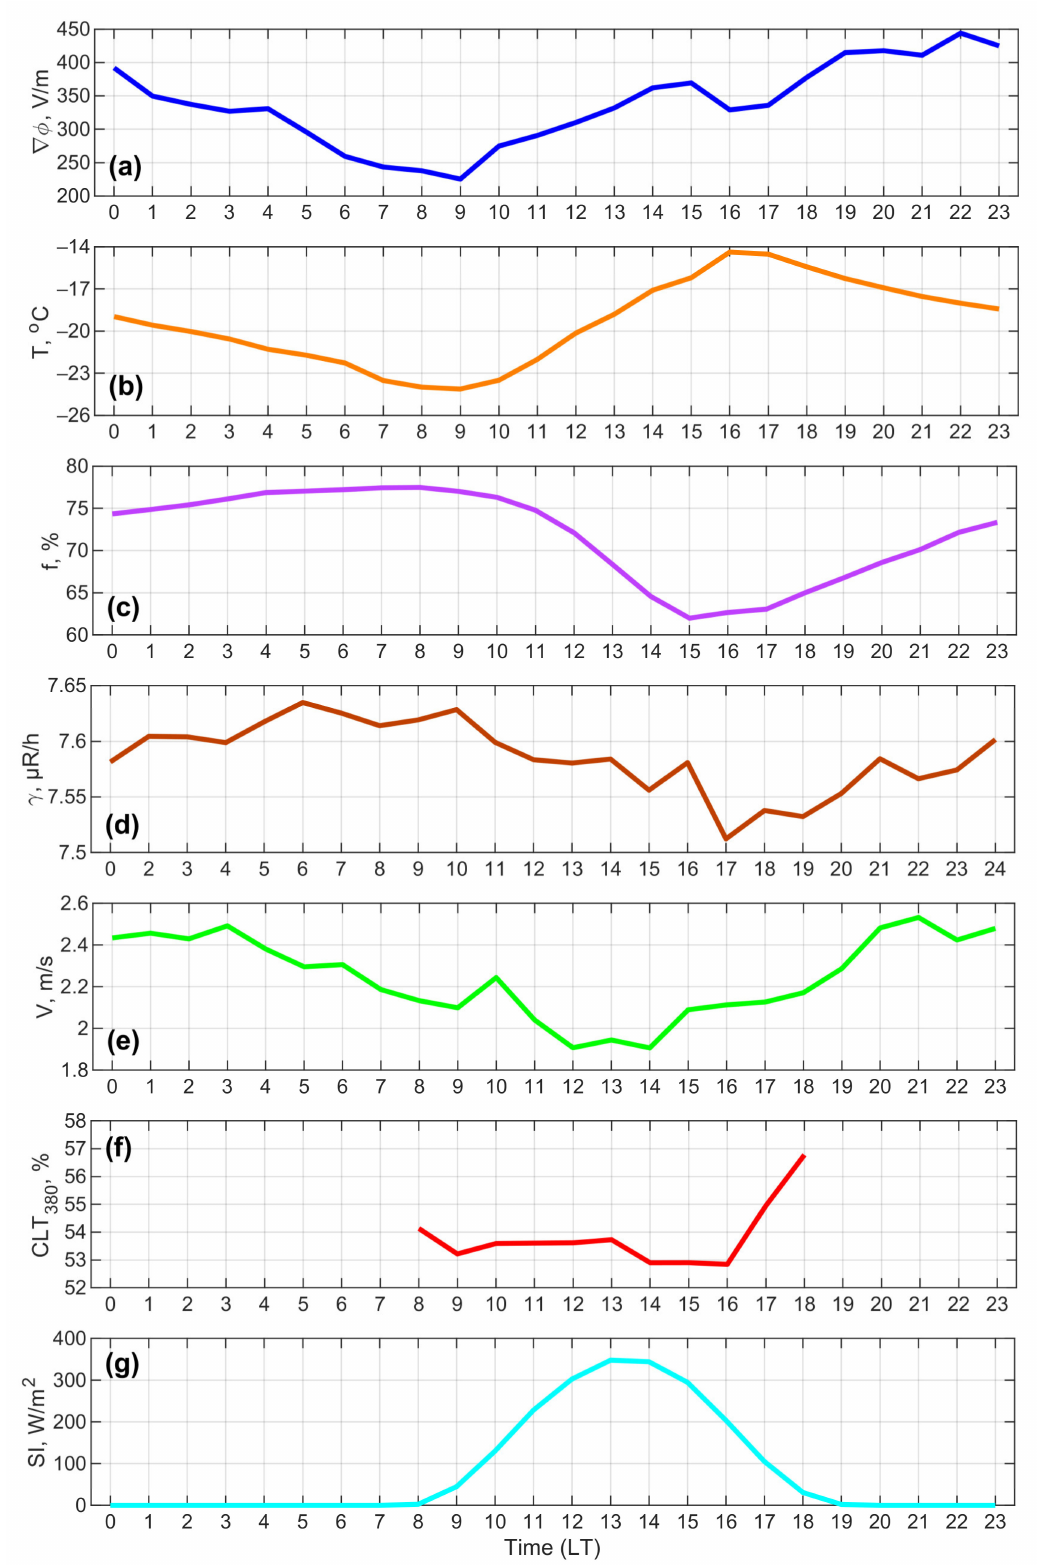
Figure A4. Variations in hourly averages of the potential gradient ( a ), air temperature ( b ), relative humidity ( c ), gamma radiation ( d ), wind speed ( e ), atmospheric transparency at 380 nm ( f ), and solar irradiance ( g ) under fair-weather conditions during February in Tomsk according to data from the IMCES GO for